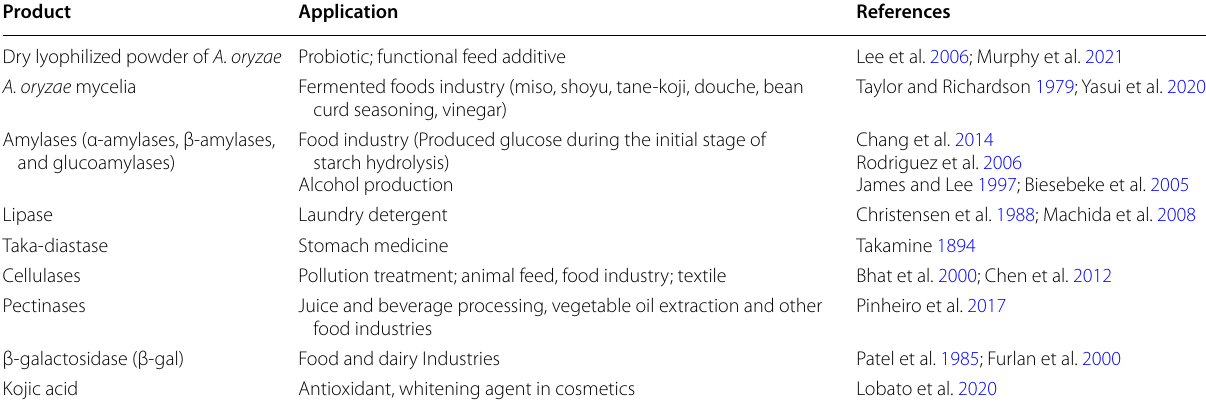
Table 1 Products of commercial values showing importance of A. oryzae as biotechnological